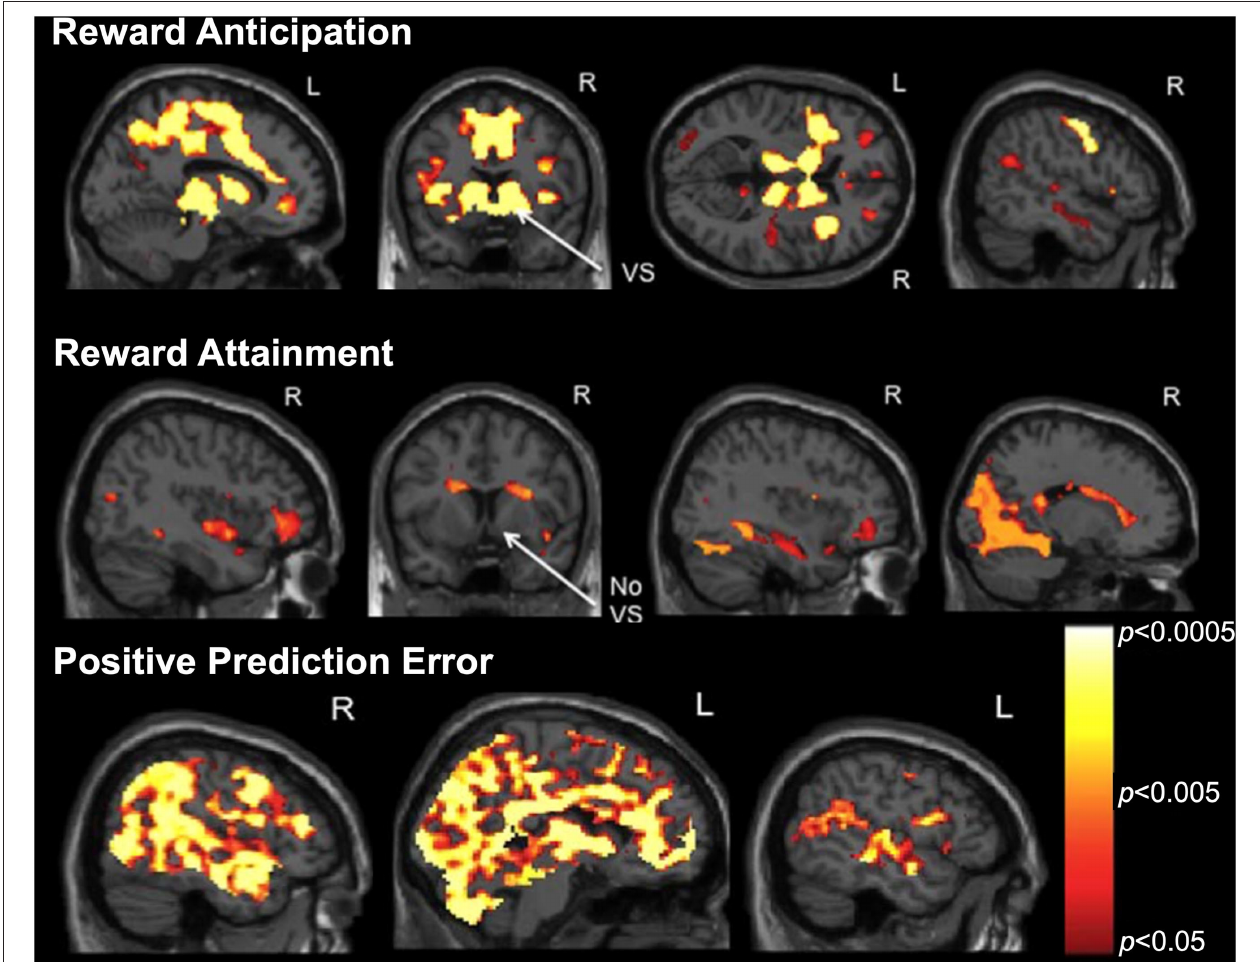
FIGURE 4 | Reward Flanker Task activation maps ( p TFCE − FWE < 0.05) from a pilot study of 22 adolescents (16 depressed, six healthy controls) showing neural responses to ( top ) reward anticipation, ( middle ) reward attainment, and ( bottom ) positive prediction error contrasts. Note the differential engagement of ventral striatum (VS) during reward anticipation but not attainment. Adapted from (